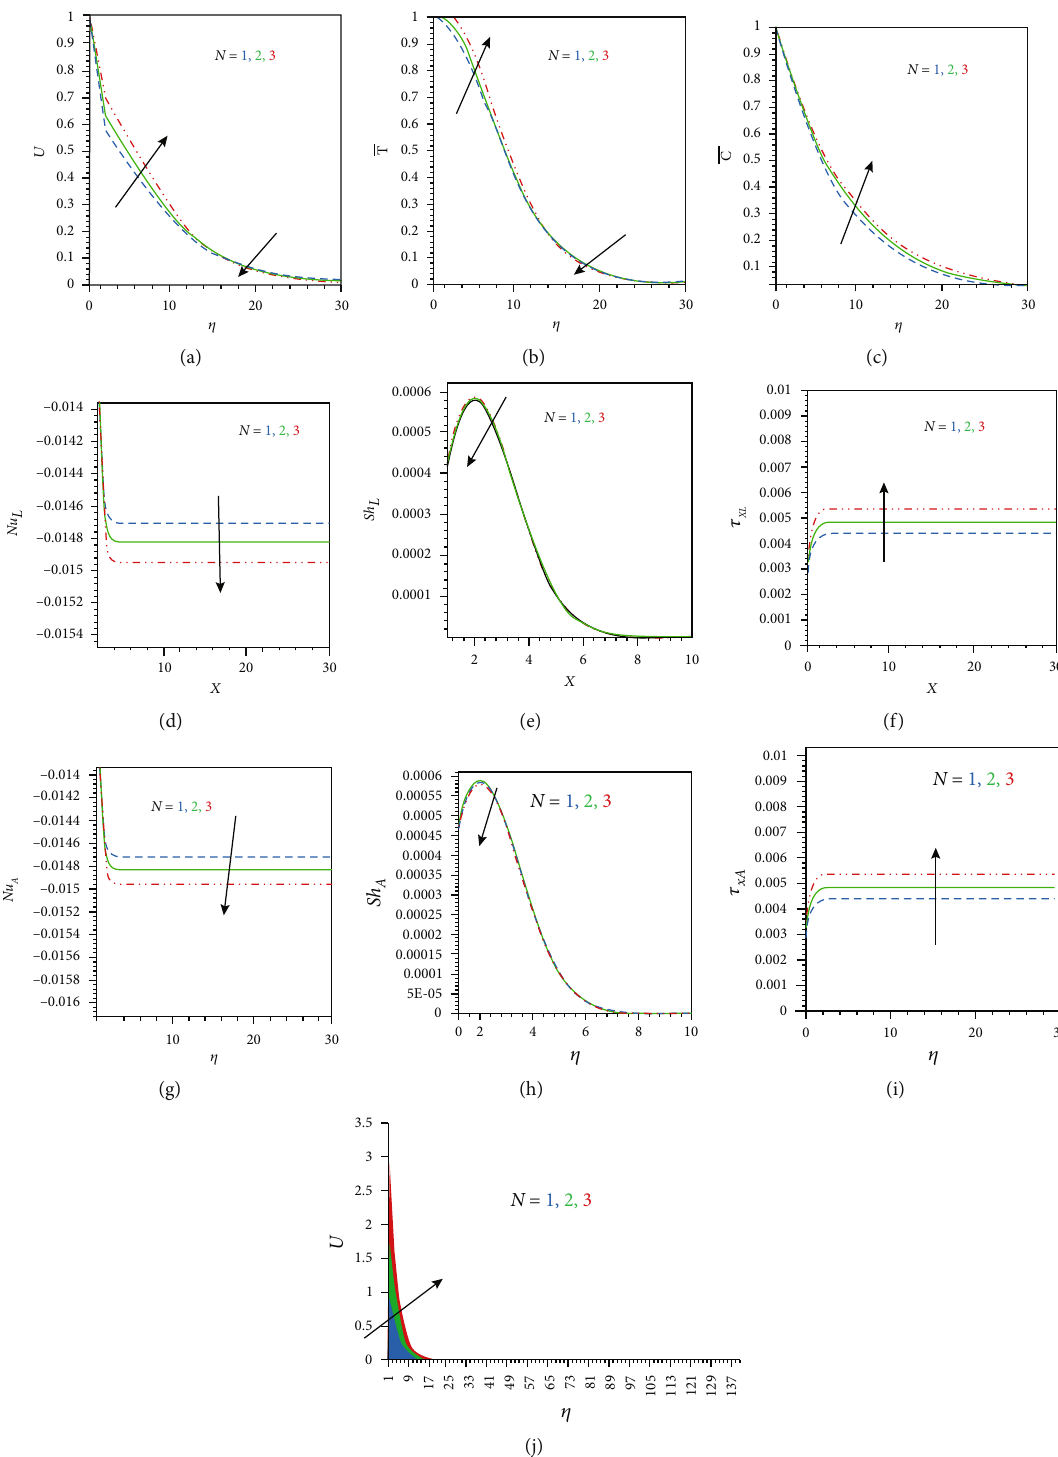
Figure 9: In fl uence of porosity on (a) fl ow, (b) thermal, (c) material fi elds, (d) Nu fi elds in the 3D plot with M = 9 : 5 , Gr = 3 : 5 , Gm = 4 : 5 , Pr = 1 , Ec = 0 : 1 , Sc = 0 : 22 , R = 1 , and H = 0 : 3